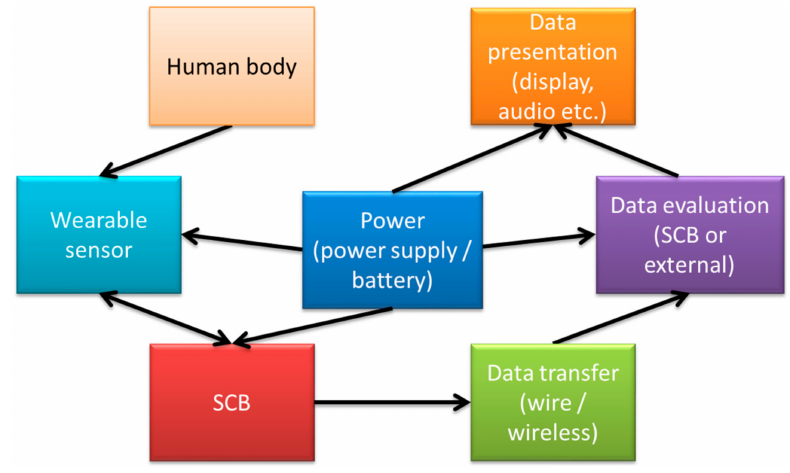
Figure 2. Block diagram of a typical measurement setup using a single circuit board